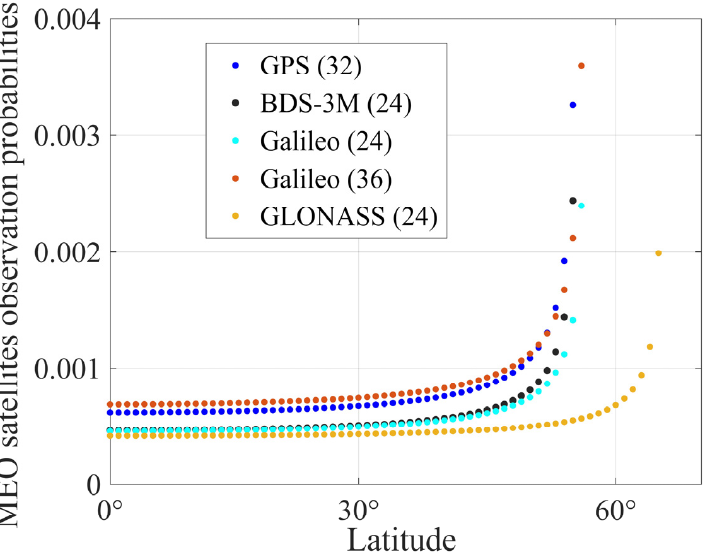
Figure 1. Distribution the observation probabilities of the GPS (32-satellite), BDS-3 MEO (BDS-3M 24-satellite), Galileo (24-satellite, and 36-satellite), and GLONASS (24-satellite) satellites.